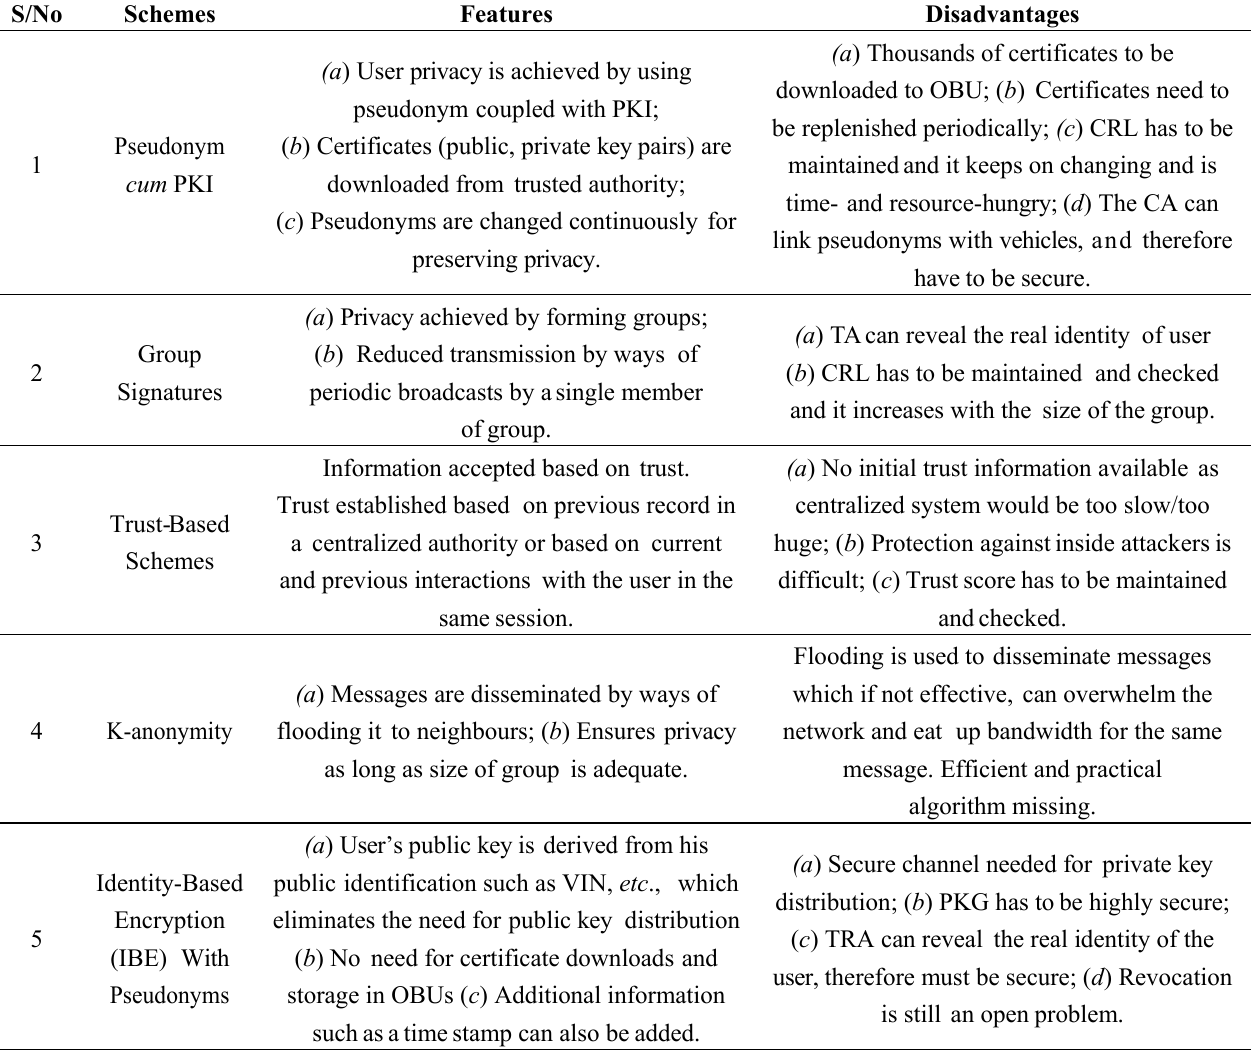
Table 2. Qualitative Comparison of Security Schemes in